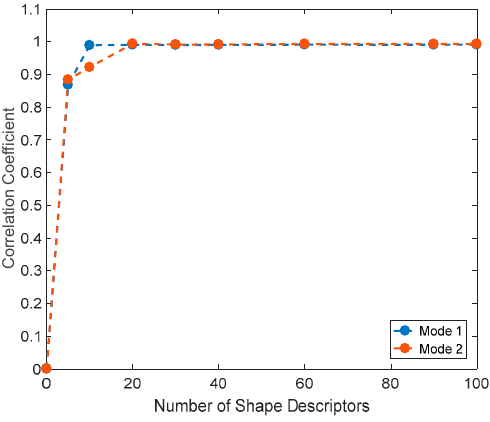
Figure 11. Evolution of the correlation coefficient between original and reconstructed displacement contours of specimen 1 as a function of the shape descriptors employed.